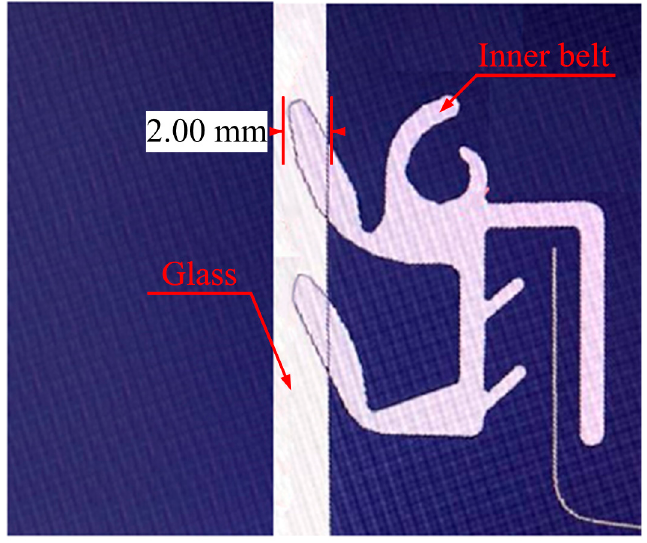
Figure 8. The interference principle diagram of the inner belt and glass.